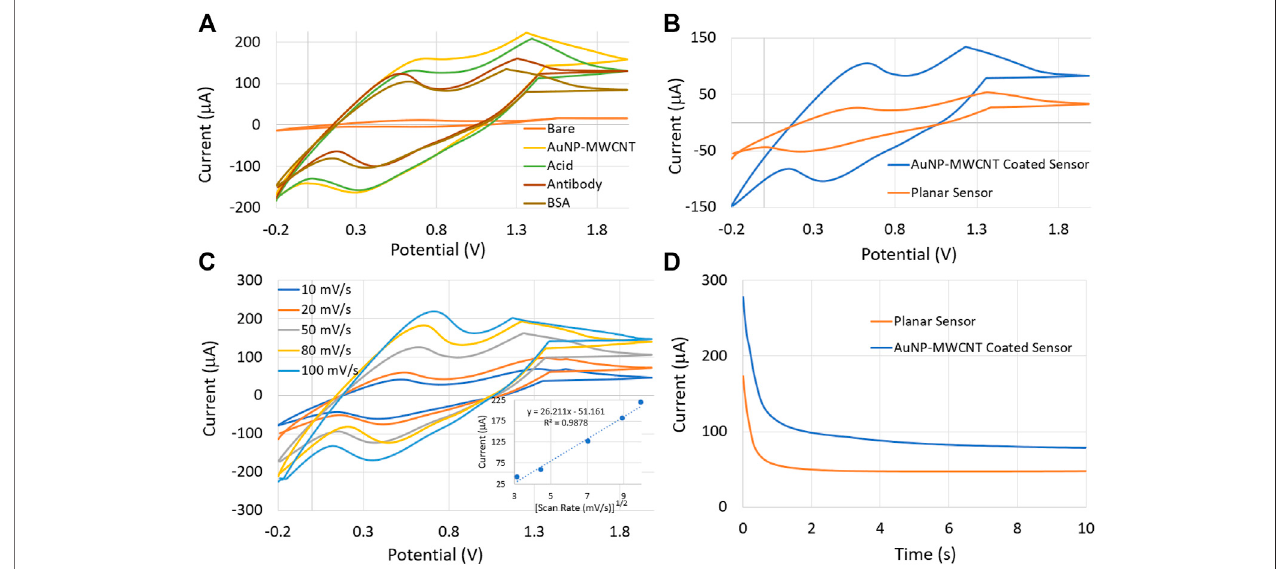
FIGURE 4 | (A) Cyclic Voltammetry (CV) plots for sequentially deposited coatings on the sensor surface. (B) CV characteristics of the AuNP-MWCNT coated and planar sensors. (C) CV characteristics as a function of scan rate. The inset demonstrates the diffusion-limited behavior of the sensor. (D) Chronoamperometry (CA) characteristics of the planar and AuNP-MWCNT coated